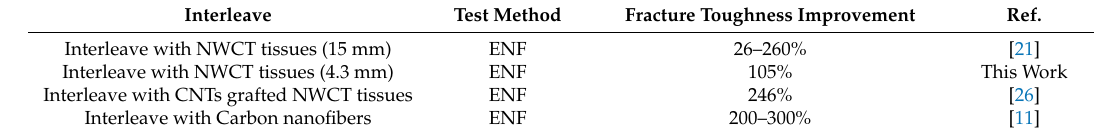
Table 2. Improvements in Mode II fracture toughness of CFRP composites with carbon interleaves.